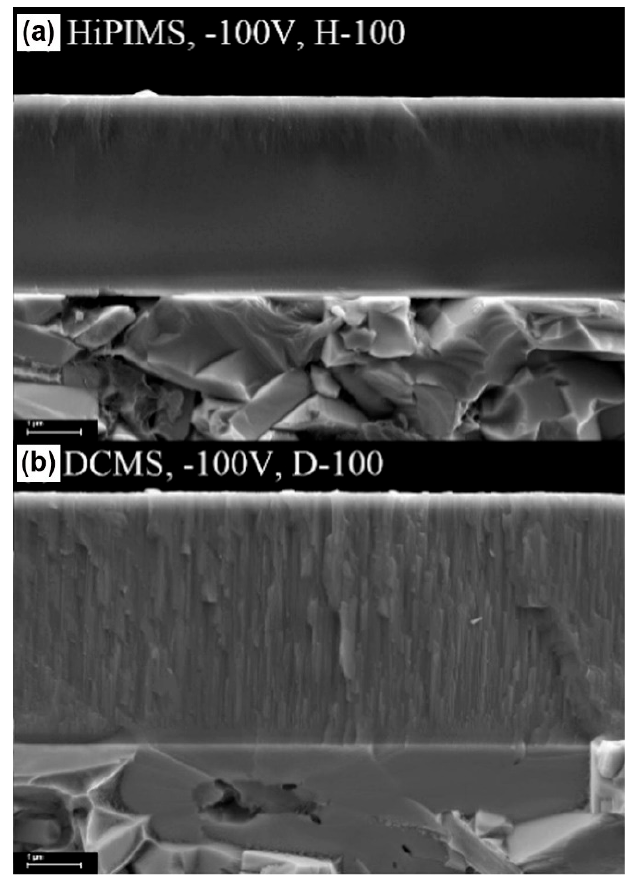
Figure 3. Cross-sectional morphology of ( a ) HiPIMS-deposited and ( b ) DC magnetron sputtering- deposited (AlCrTiVZr)N films. Figure reproduced and modified with permission of ref. [56]. Copyright 2021 Applied Surface Science.